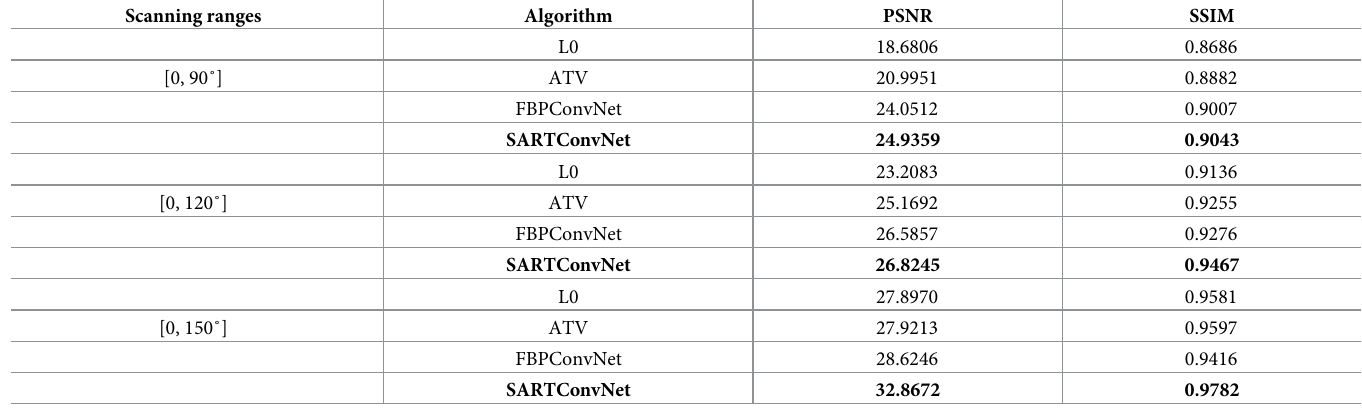
Table 2. Quantitative results associated with different algorithms for the abdomen image from different angle projection data. Scanning